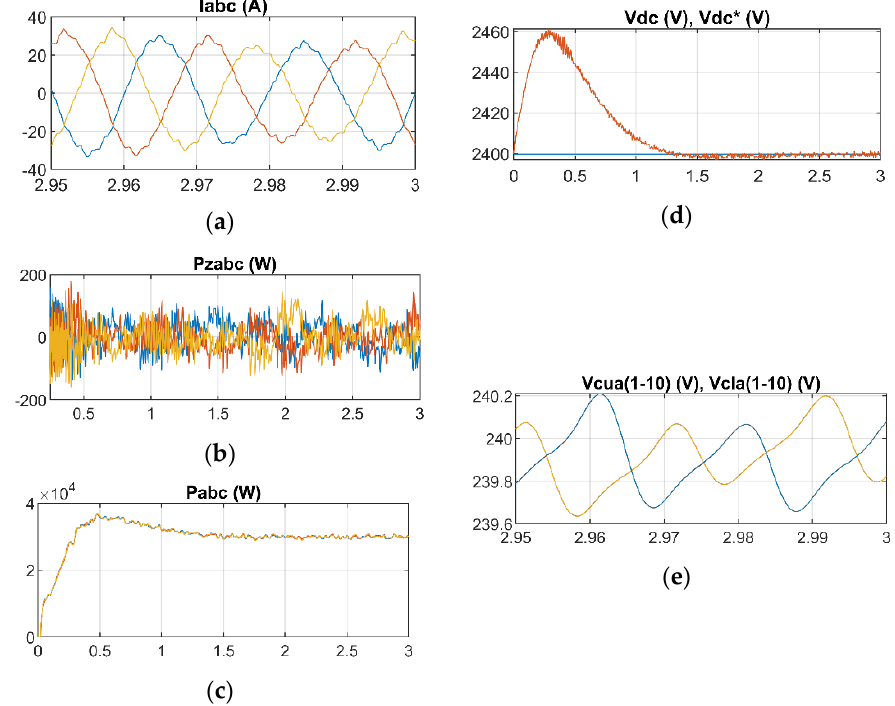
Figure 8. Simulation graphics when the generation is balanced and the power is full. ( a ) Output currents. ( b ) Power transferred between phases. ( c ) Power delivered by each phase. ( d ) Voltage on the DC link. ( e ) Capacitor voltages.